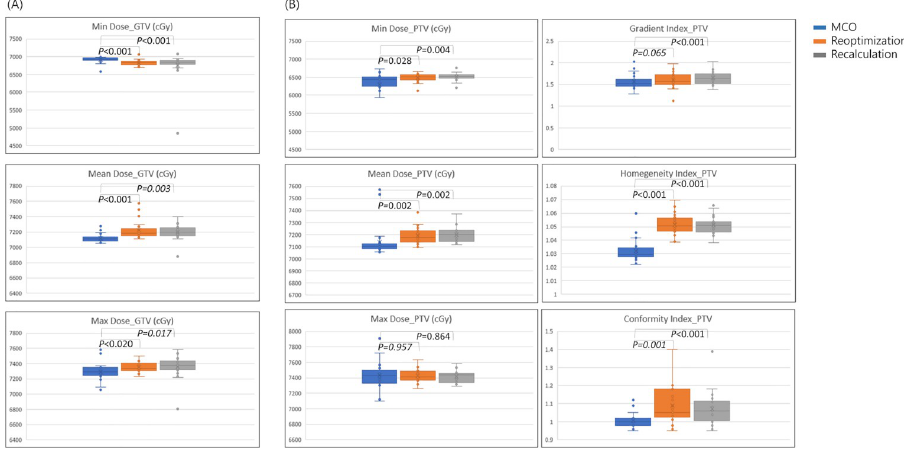
Fig 4. Boxplots of (A) D min , D mean , and D max for GTVs, and (B) D min , D mean , D max , GI, HI, and CI for PTV. Abbreviations: D min , Minimum dose; D mean , mean dose; D max , maximum dose; GI, gradient index; HI, homogeneity index; CI, conformal